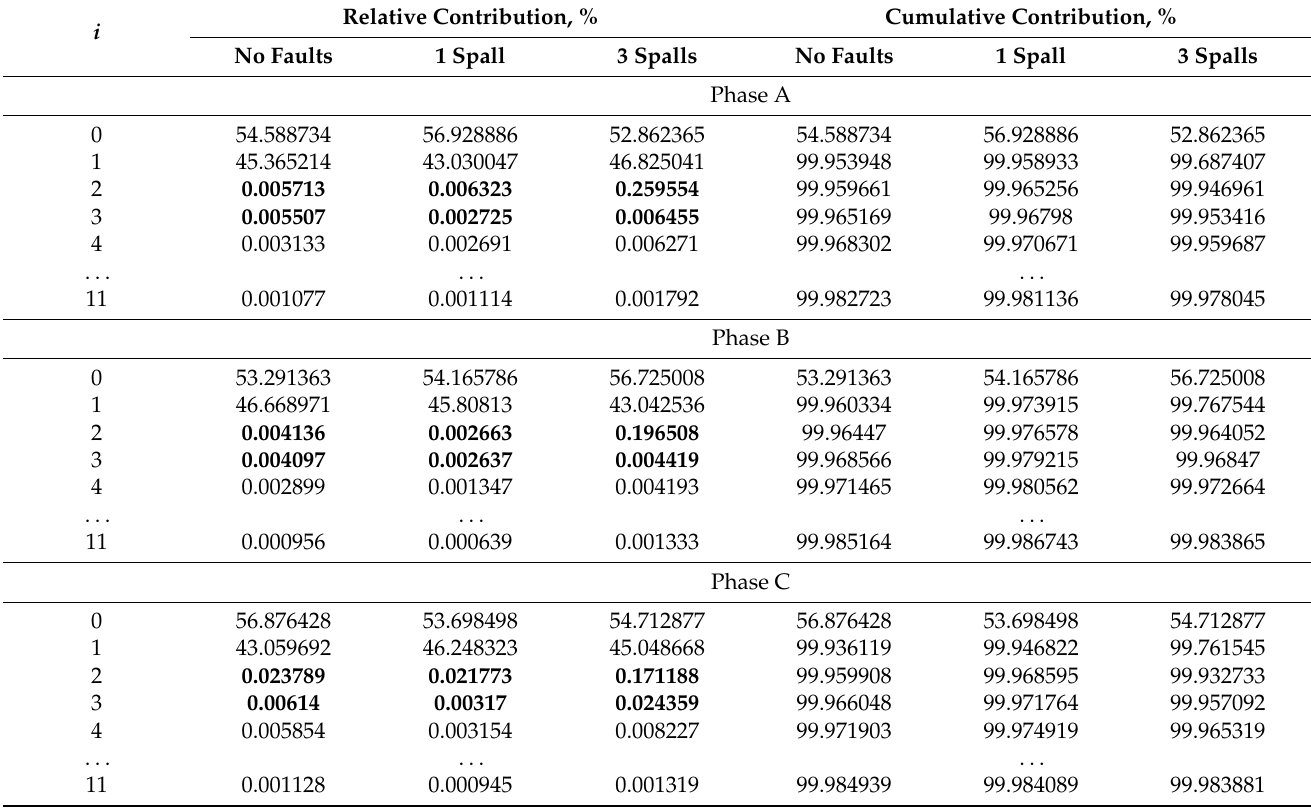
Table 3. Comparison of the results obtained from the component contribution calculations.